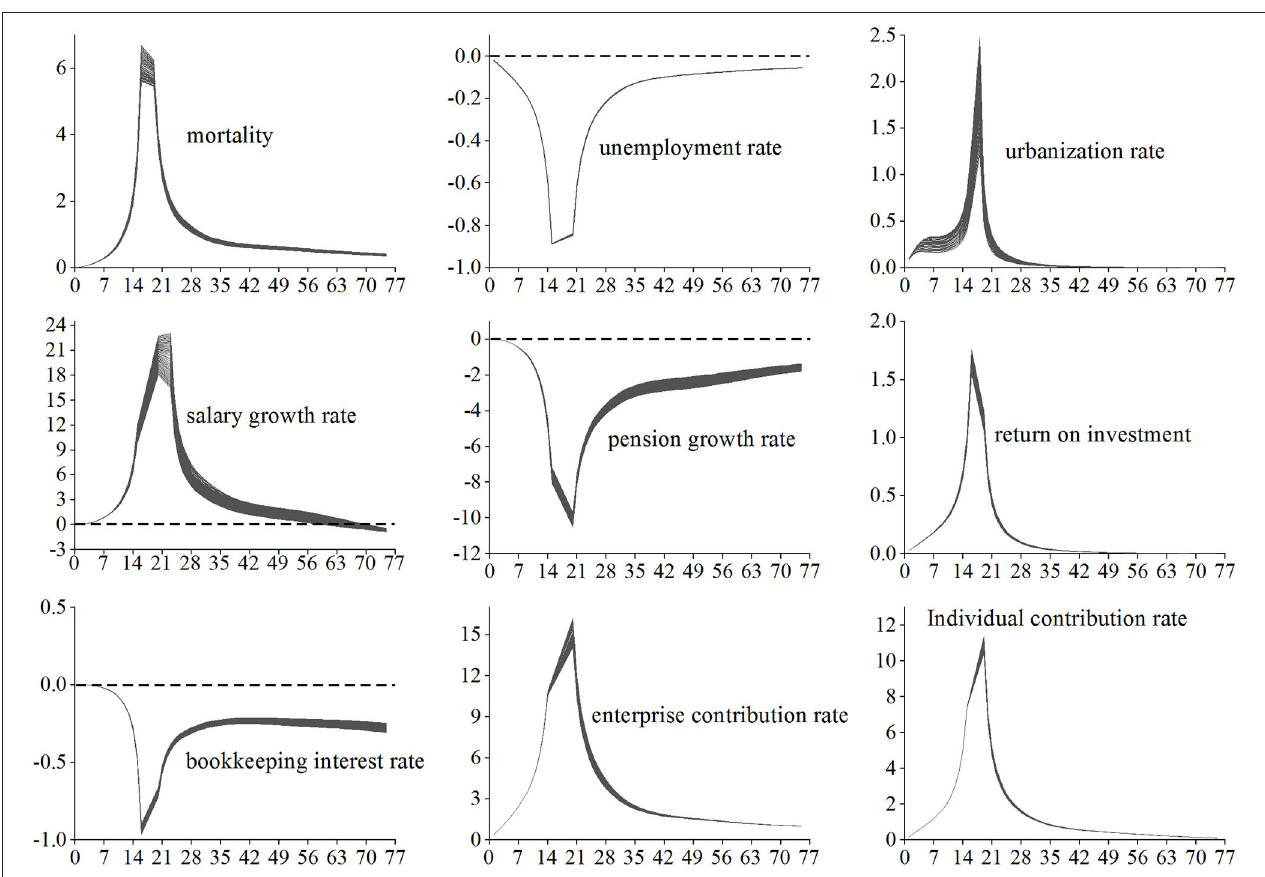
FIGURE 5 | Elasticity of accumulated balance to each main